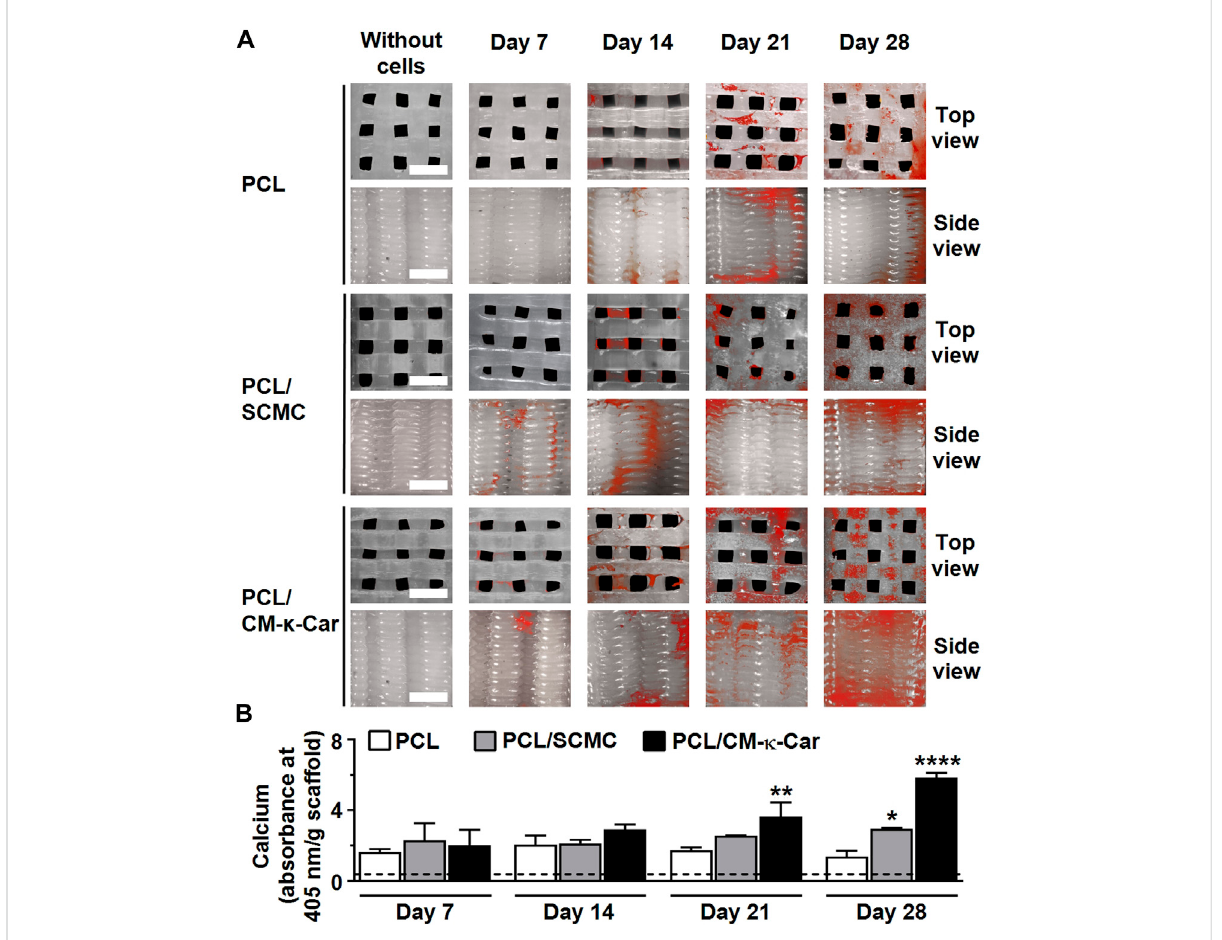
FIGURE 9 Effectof3D-printedPCLscaffold surface-functionalizationbySCMCorCM- κ -CaronmatrixmineralizationbyMC3T3-E1pre-osteoblasts after 7, 14, 21, and 28 days. (A) Mineral deposition staining (alizarin red). Scale bar: 1.5 mm. (B) Quanti fi ed mineral content. Values are mean ± SD ( n = 3). *Signi fi cantly different from control 3D-printed PCL scaffolds, p < 0.05, ** p < 0.005, **** p < 0.0001. PCL, polycaprolactone; SCMC,